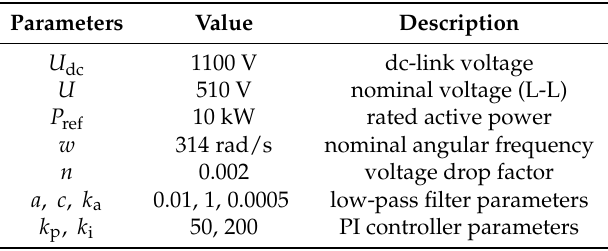
Table 2. The Parameters of VSG